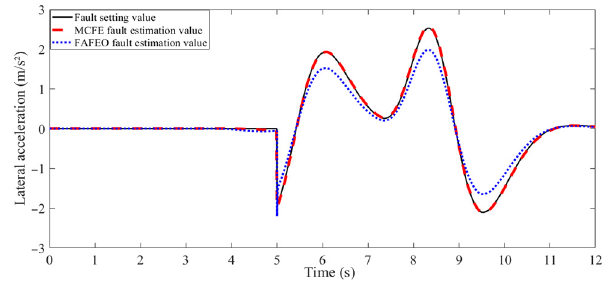
Figure 18 Fault estimation curve of the lateral acceleration sensor